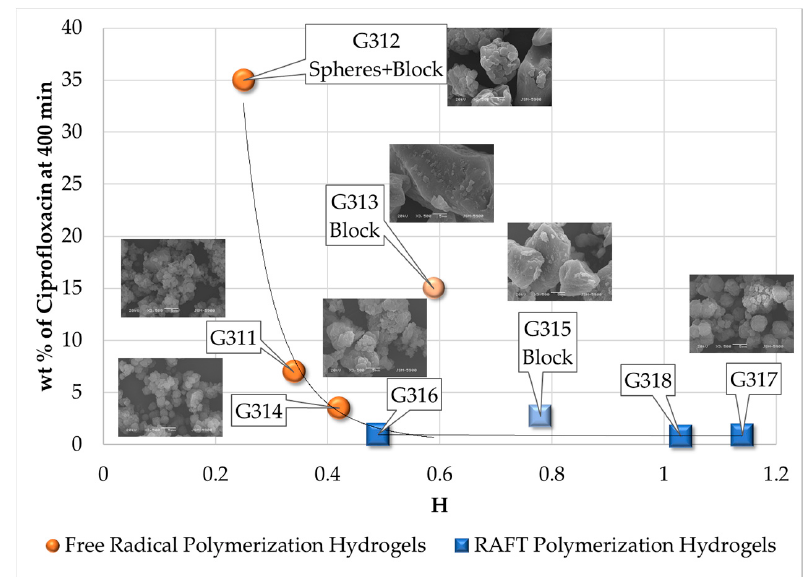
Figure 18. Relationship among the amount of ciprofloxacin released at 400 min from hydrogels, morphology and H .